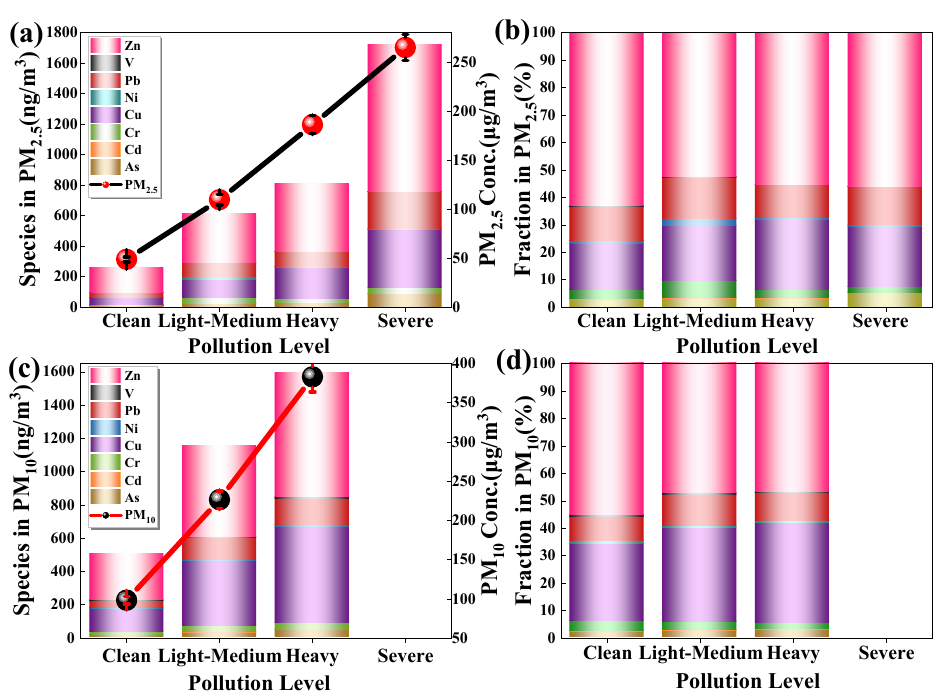
Figure 4. ( a , b ) are the content and percentage of heavy metals in PM 2.5 at different pollution levels; ( c , d ) are the content and percentage of heavy metals in PM 10 at different pollution levels.